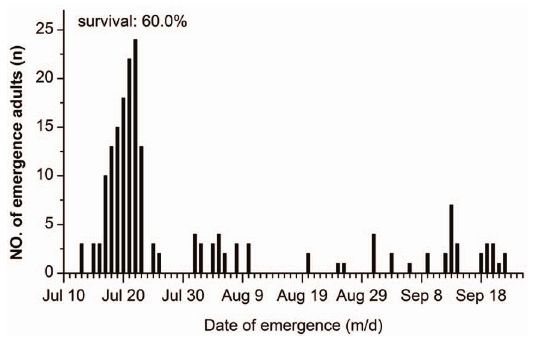
Figure 6. Frequency distribution of adult eclosion in pupae of H. cunea under natural conditions in Nanchang. Pupae were collected in Qingdao city and transferred to Nanchang in early July (n=187).